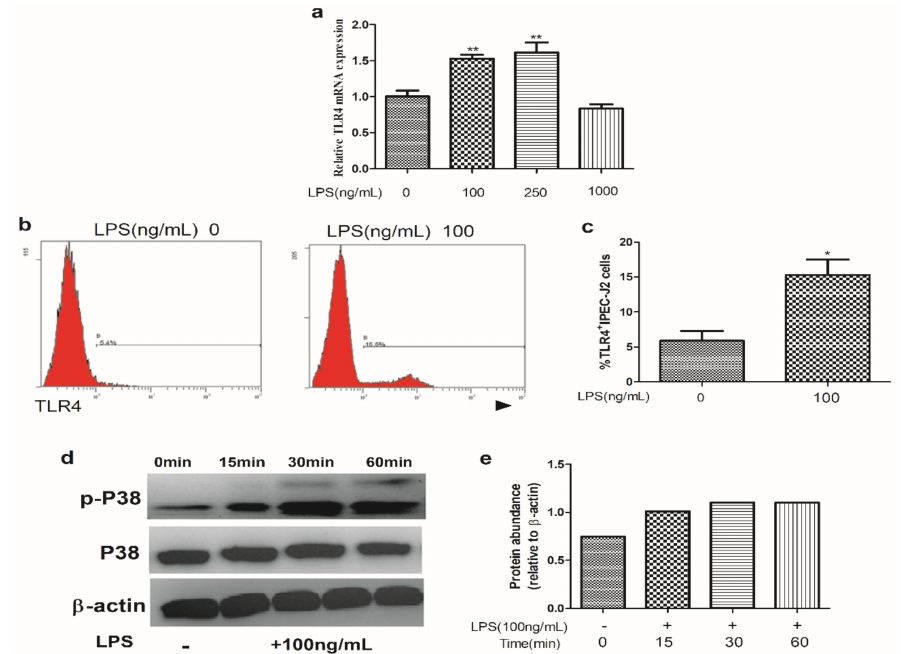
Figure 1. E ff ect of LPS on TLR4 and P38 expression. ( a ) IPEC-J2 cells were treated with di ff erent concentrations of LPS for 24 h, and then were collected for analysis of the relative expression of TLR4 mRNA. ( b ) Representative flow cytometric histograms demonstrated that the levels of TLR4 in IPEC-J2 cells. ( c ) Summary data showing the expression level of TLR4 in IPEC-J2 cells stimulated with 0 or 100 ng / mL LPS. ( d ) The protein levels of p38 and p-p38 were determined by Western blotting. Equal protein loading was confirmed by analysis of β -actin in the protein extracts. ( e ) The ratios of p-p38 to β -actin in IPEC-J2 cells treated with 100 ng / mL LPS for 0, 15, 30, and 60 min. Data are means ± SEM. * p < 0.05, ** p < 0.01. TLR4, Toll-like receptor 4.